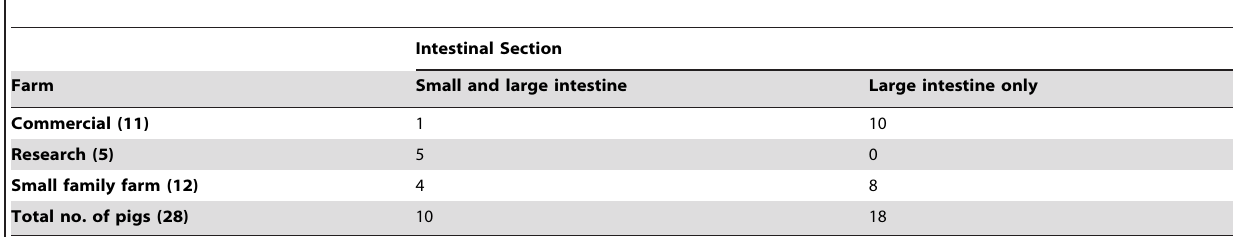
Table 2. Frequency of detection of Blastocystis in porcine intestinal segments using PCR (nested and ST-specific primers) in small versus large